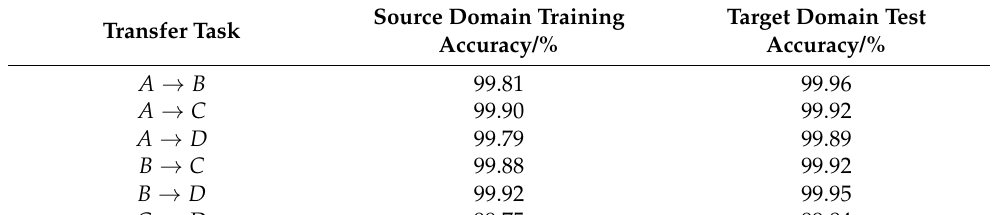
Table 7. Fault diagnosis results.